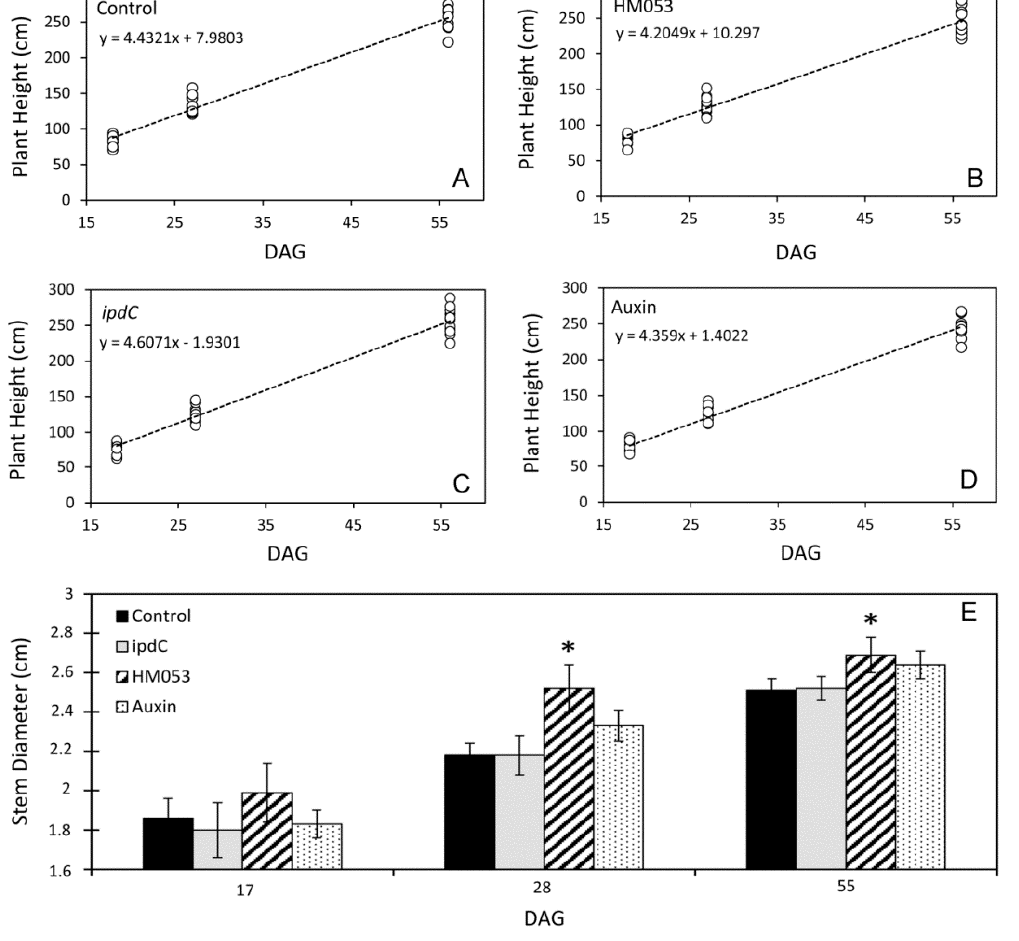
Figure 2. Plant growth rates measured as plant height and stem diameter over time. Plant heights were measured from top of soil to tallest point on shoots during the 2019 growing season spanning 17–55 days after germination (DAG). No significant di ff erence was observed in growth rates across the treatment types. Panels ( A–D ): based on a comparison of growth rate slopes derived from linear regression analysis. Stem diameters were measured in centimeters at the second internode from the base of the stem. A significant increase in stem thickness was recorded for A. brasilense HM053 relative to non-inoculated control maize. Data ( ± SE) reflects N = 12 biological replicates. Asterisks indicate significant di ff erences (* p < 0.05) using Student paired t-test comparing treated to non-treated control plant stems when measured at the second internode, in which, at 28 and 55 days after germination, A. brasilense HM053-inoculated maize exhibited a significantly increased stem thickness relative to non-inoculated control, suggesting the biologic improved plant growth.